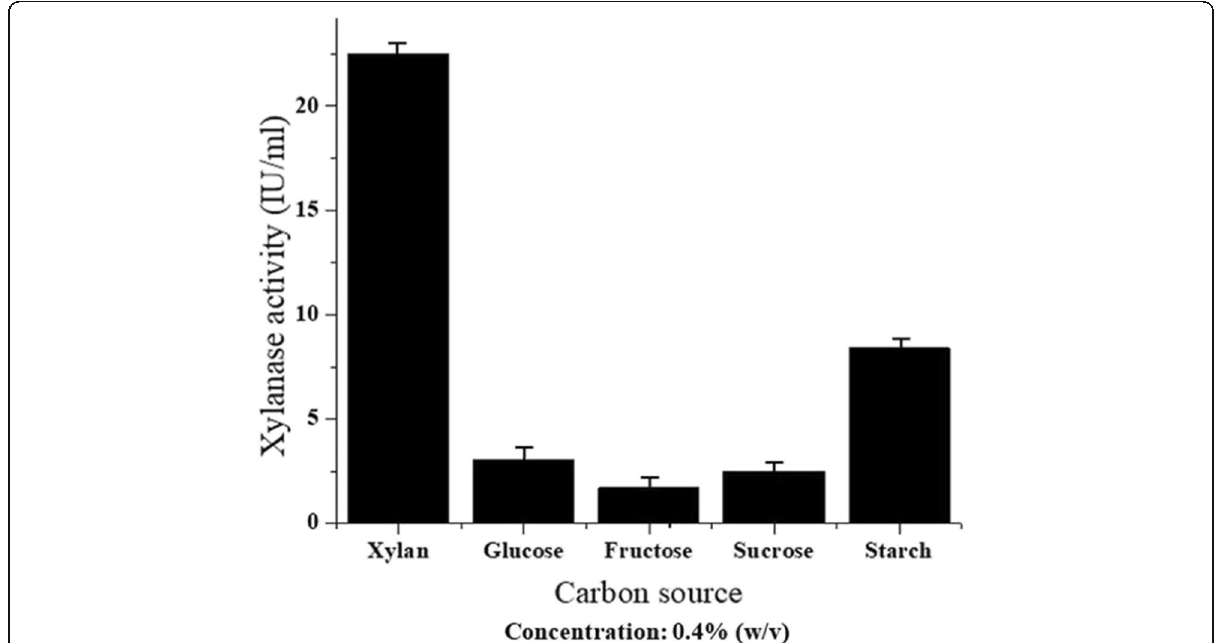
Fig. 5 Effect of different carbon sources on xylanase activity of the bacterium Pseudomonas